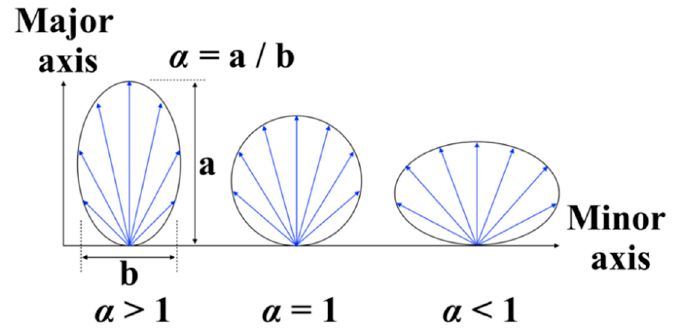
Figure 4. Three different situations of angular distribution.